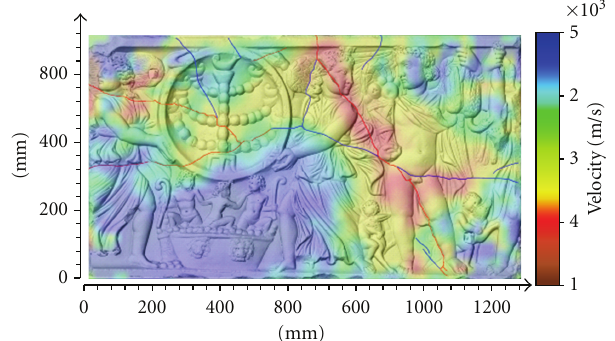
Figure 7: GPR tomography superimposed to slab